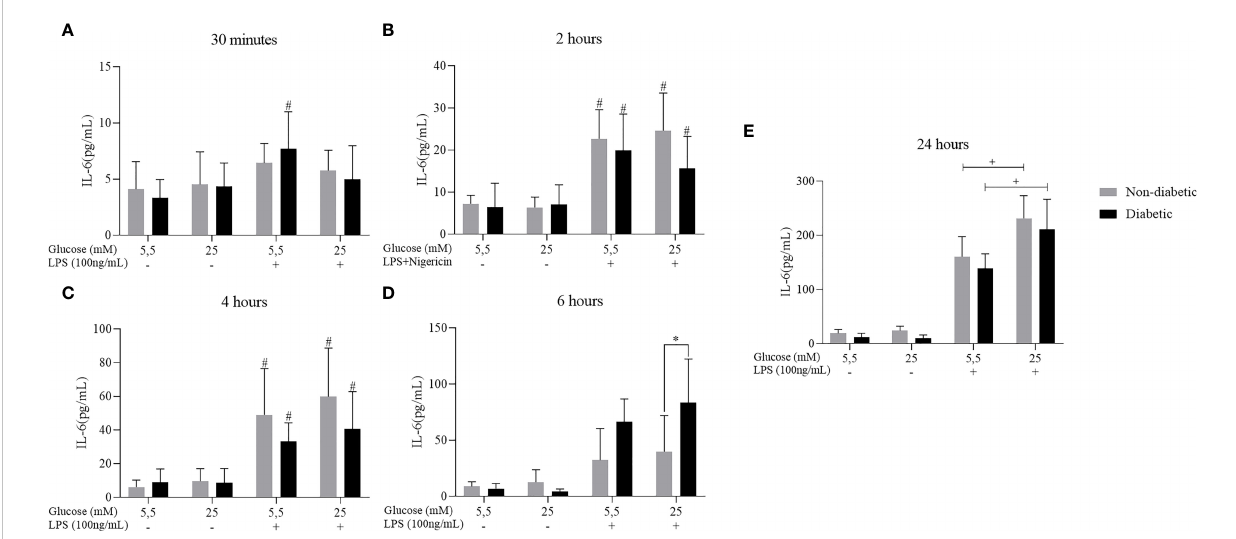
FIGURE 4 IL-6 secretion by ND-BMDM and D-BMDM with Nigericin priming and LPS stimulation. IL-6 release after (A) 30 minutes with different glucose concentrations. #P<0.05 D-BMDM 5.5Mm+ vs D-BMDM 5.5mM-. (B) 2 hours with different glucose concentrations. #P<0.05 stimulated groups vs non stimulated. (C) 4 hours with different glucose concentrations. #P<0.05 stimulated vs non stimulated. (D) 6 hours with different glucose concentrations. *P<0.05 D-BMDM 25Mm+ vs ND-BMDM 25mM-. (E) 24 hours with different glucose concentrations. +P<0.05 5.5mM+ vs 25mM+. IL-6 measurement was performed by enzyme-linked immunosorbent assay. Results represent mean ± SEM. N = 7-13. BMDM: Bone-Marrow Derived Macrophages, from diabetic (D-) and non-diabetic (ND-) C57BL/6